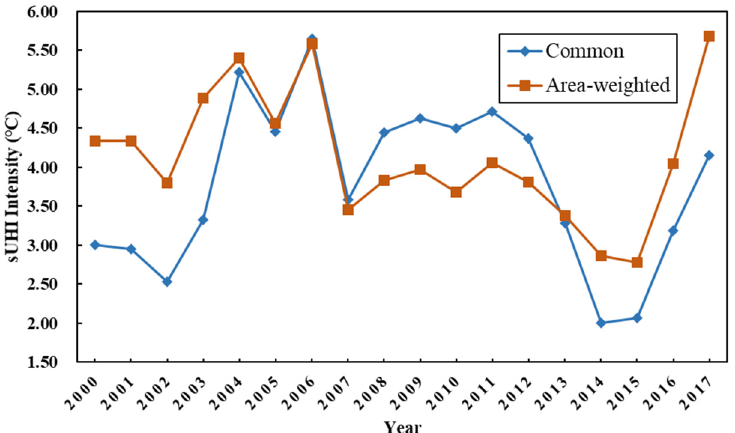
Figure 9. sUHI Intensity variation based on the LCZ scheme from 2000 to 2017.